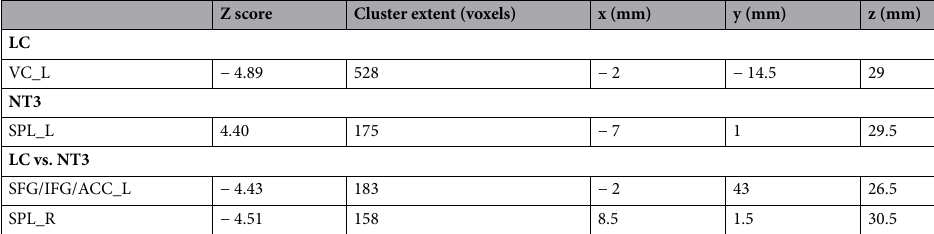
Table 2. Longitudinal brain structural alterations in the LC and NT3 animals. LC lesion control, NT3 neurotrophin-3, L left, R right, VC visual cortex, SPL superior parietal lobule, SFG superior frontal gyrus, IFG inferior frontal gyrus, ACC anterior cingulate